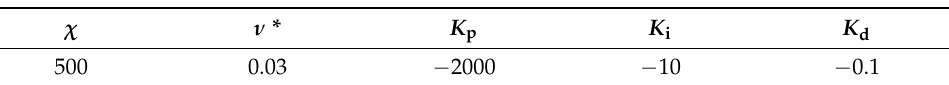
Table 4. Parameters of the IPID controller.